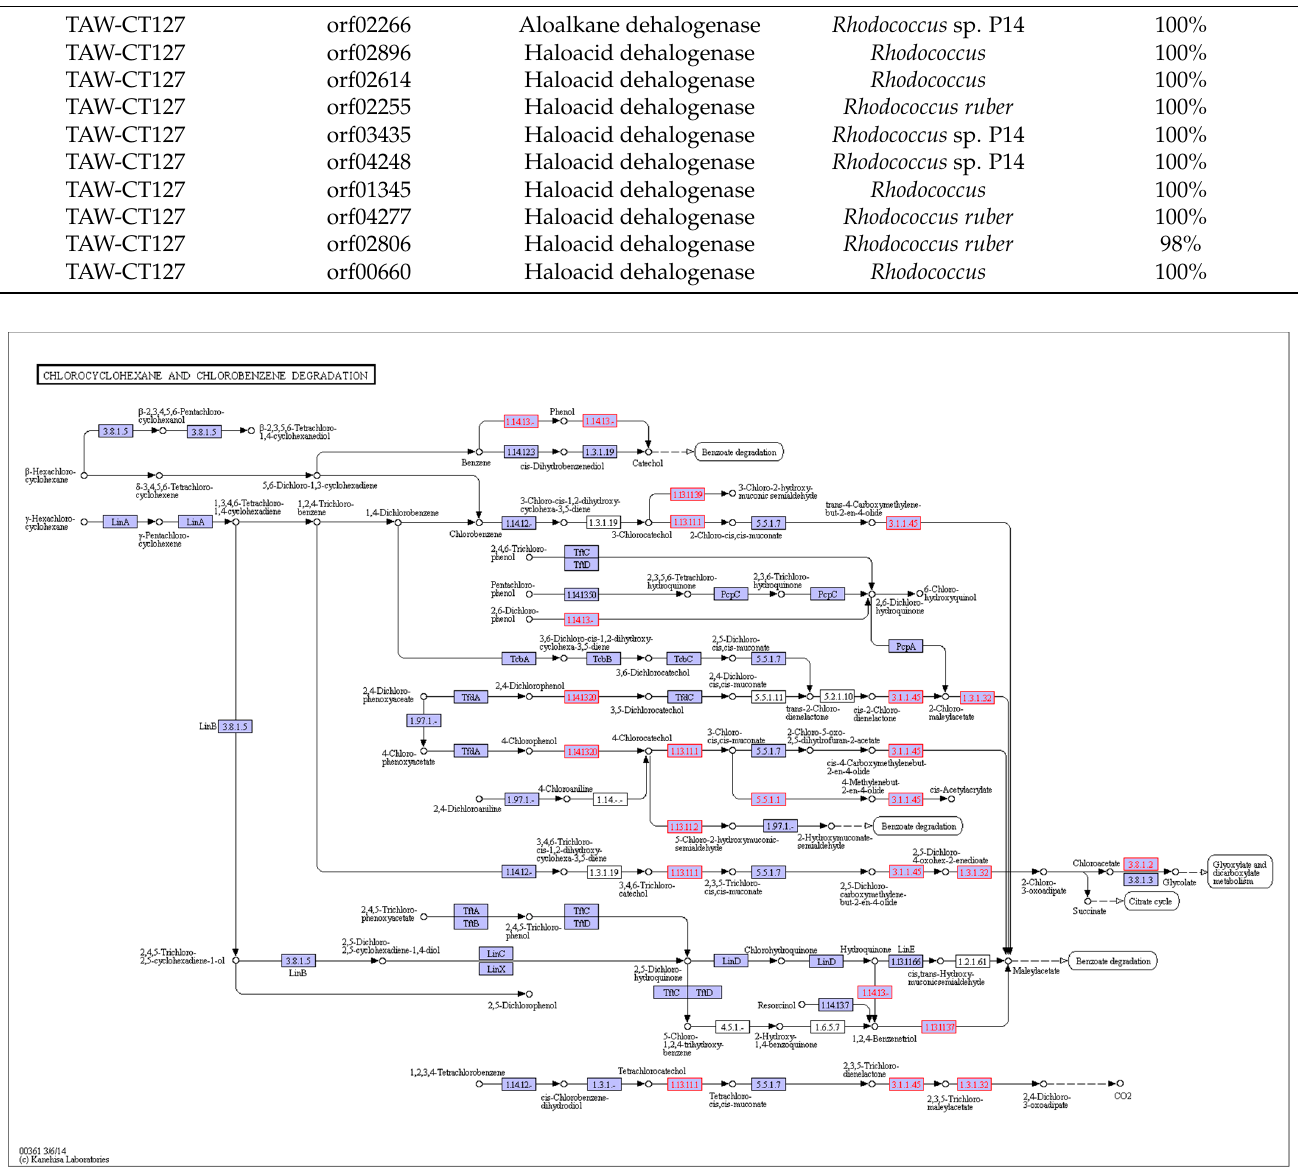
Figure 8. Chlorocyclohexane and chlorobenzene degradation in TAW-CT127.